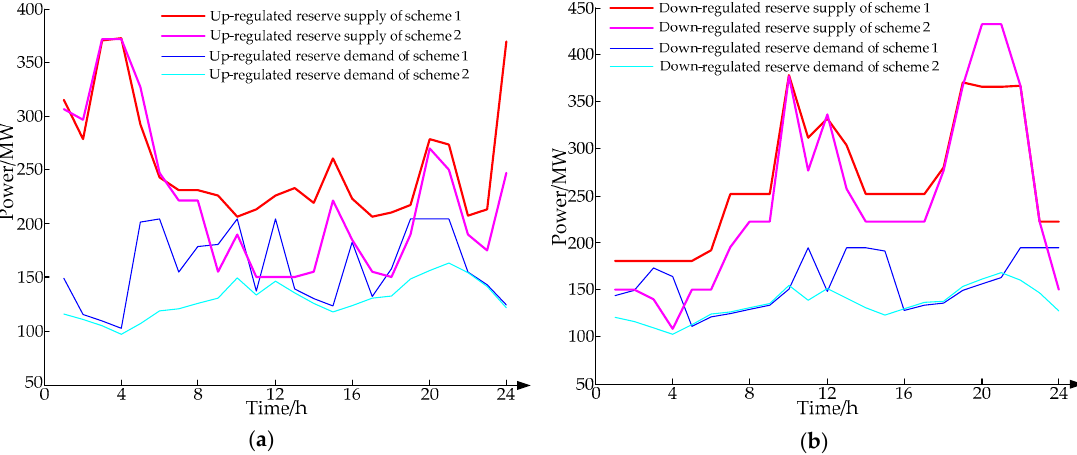
Figure 11. Comparison of reserve demand and supply under di ff erent scheme: ( a ) Up-regulated reserve comparison; ( b ) Down-regulated reserve comparison.